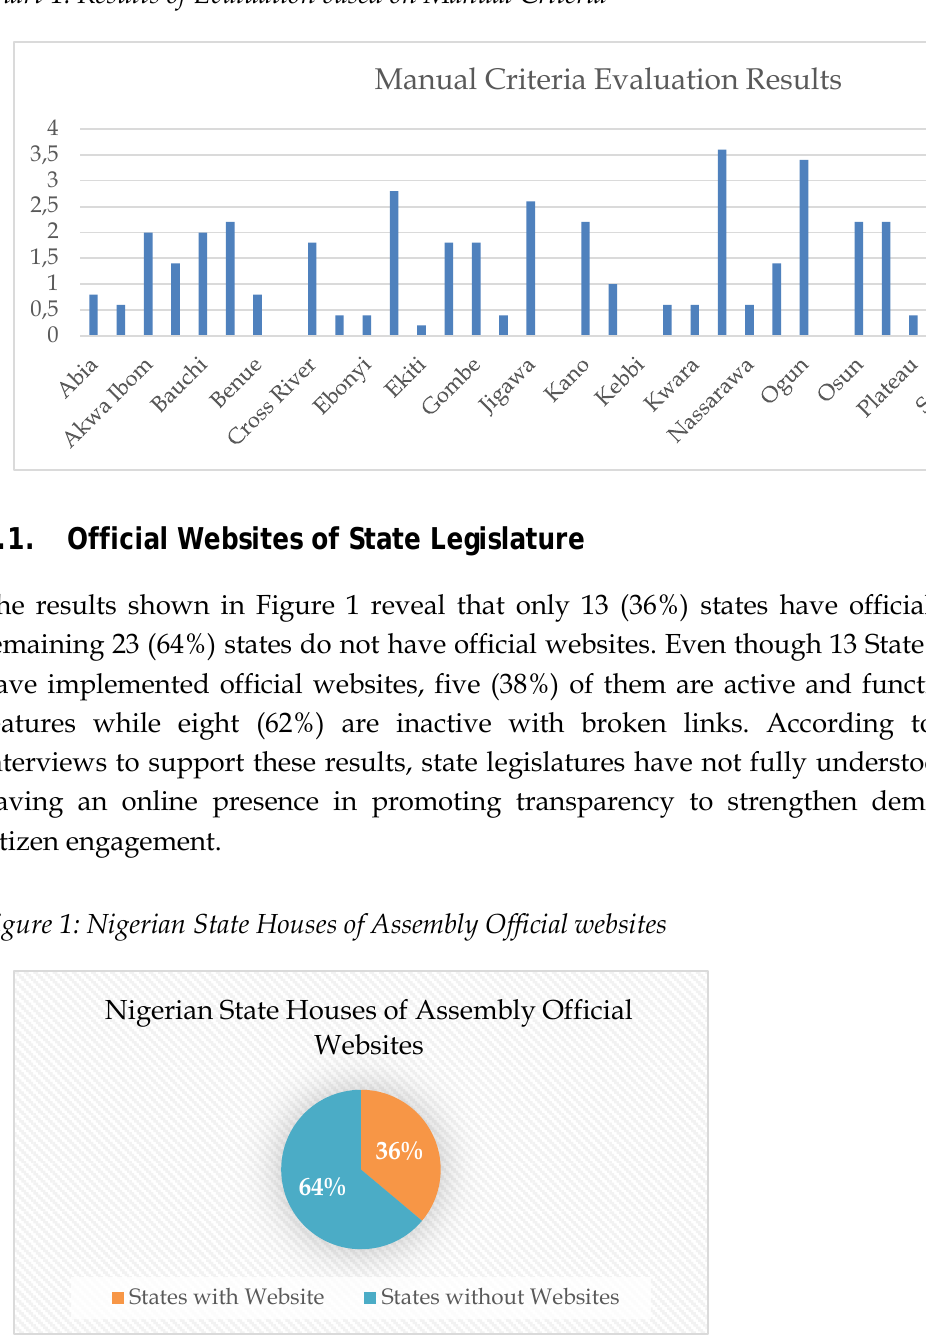
Chart 1: Results of Evaluation based on Manual Criteria